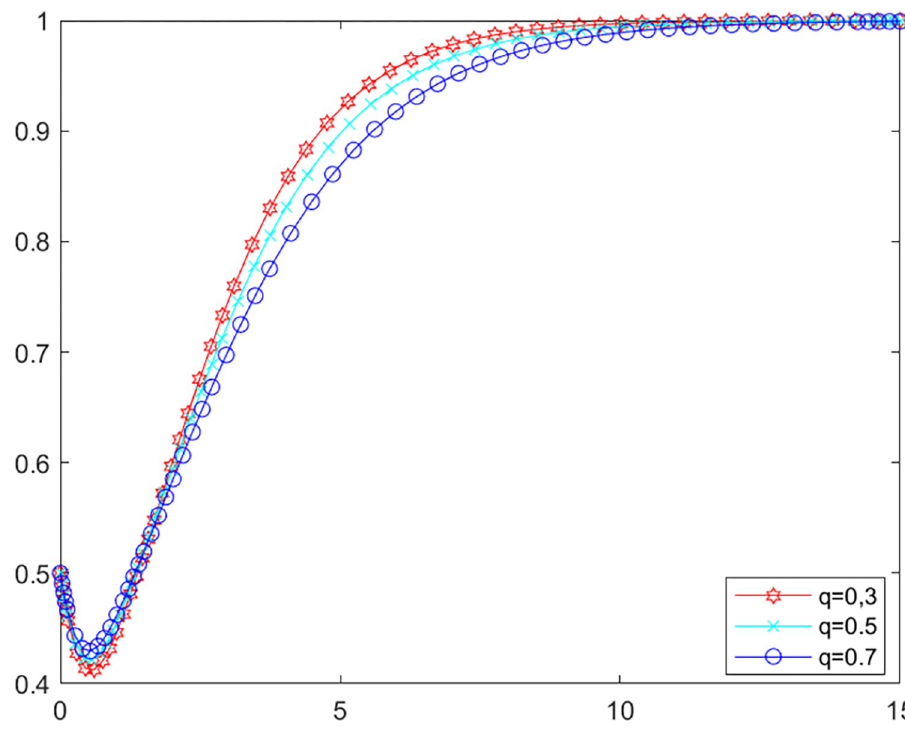
Fig 11. LPBE’s evolutionary path ( α =